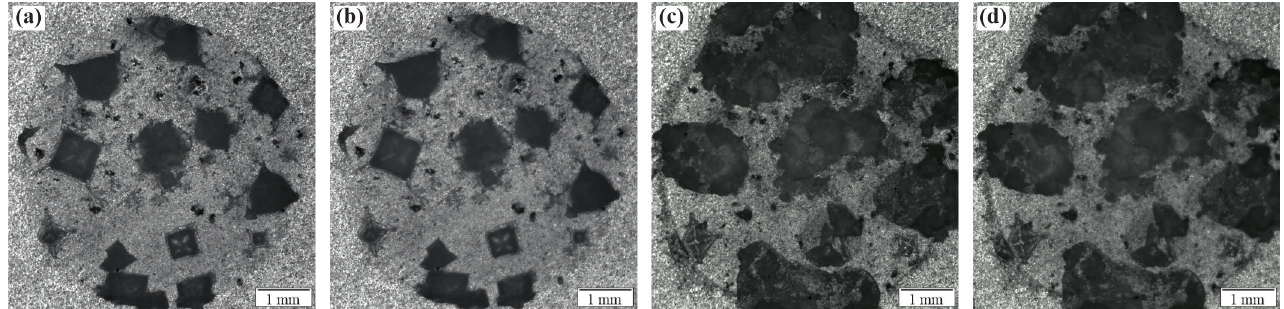
Figure 6. No progress in the corrosion during the defined dry phase, i.e., no difference can be seen between the corroded specimen surfaces ( a ) at hour 23.5 and ( b ) at hour 27.5. There was also no progress in the corrosion after the final evaporation of the droplet. ( c ) The specimen surface at hour 77.7 and ( d ) at hour